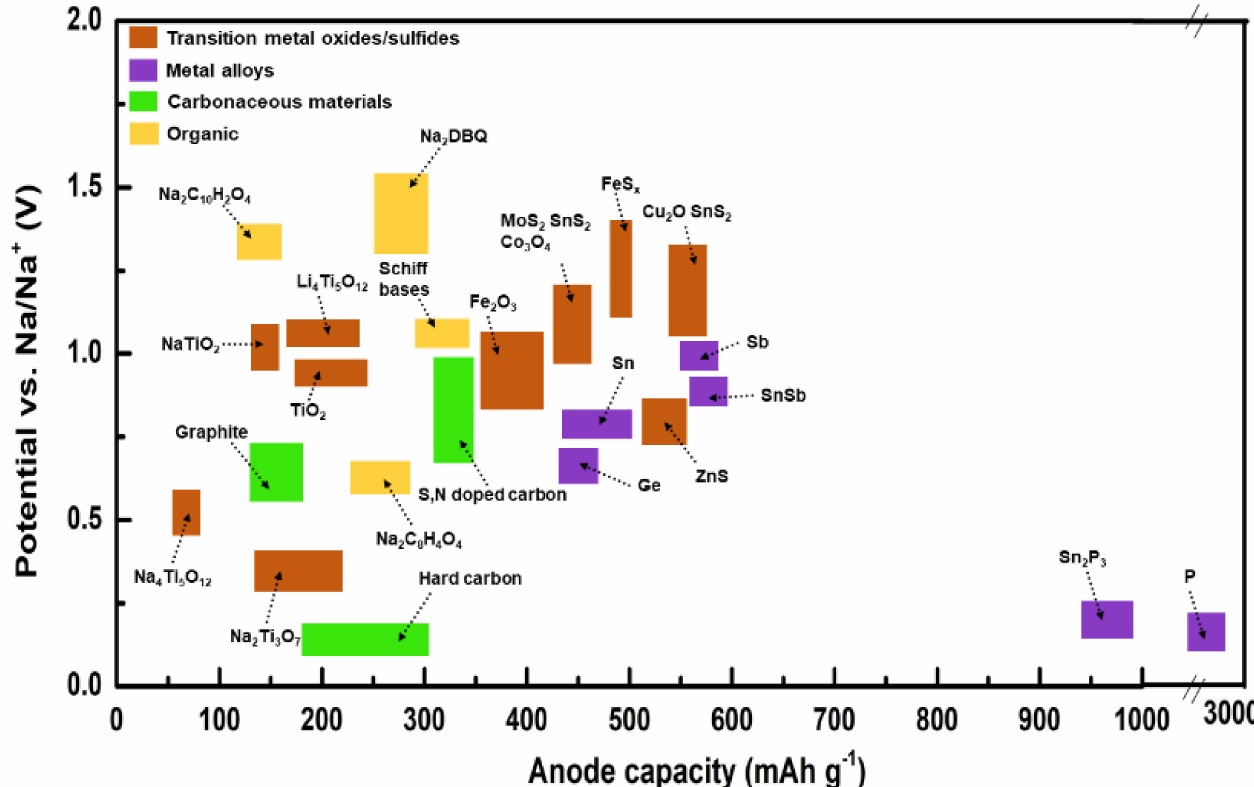
Figure 11. Specific capacities of anode materials used in Na-based